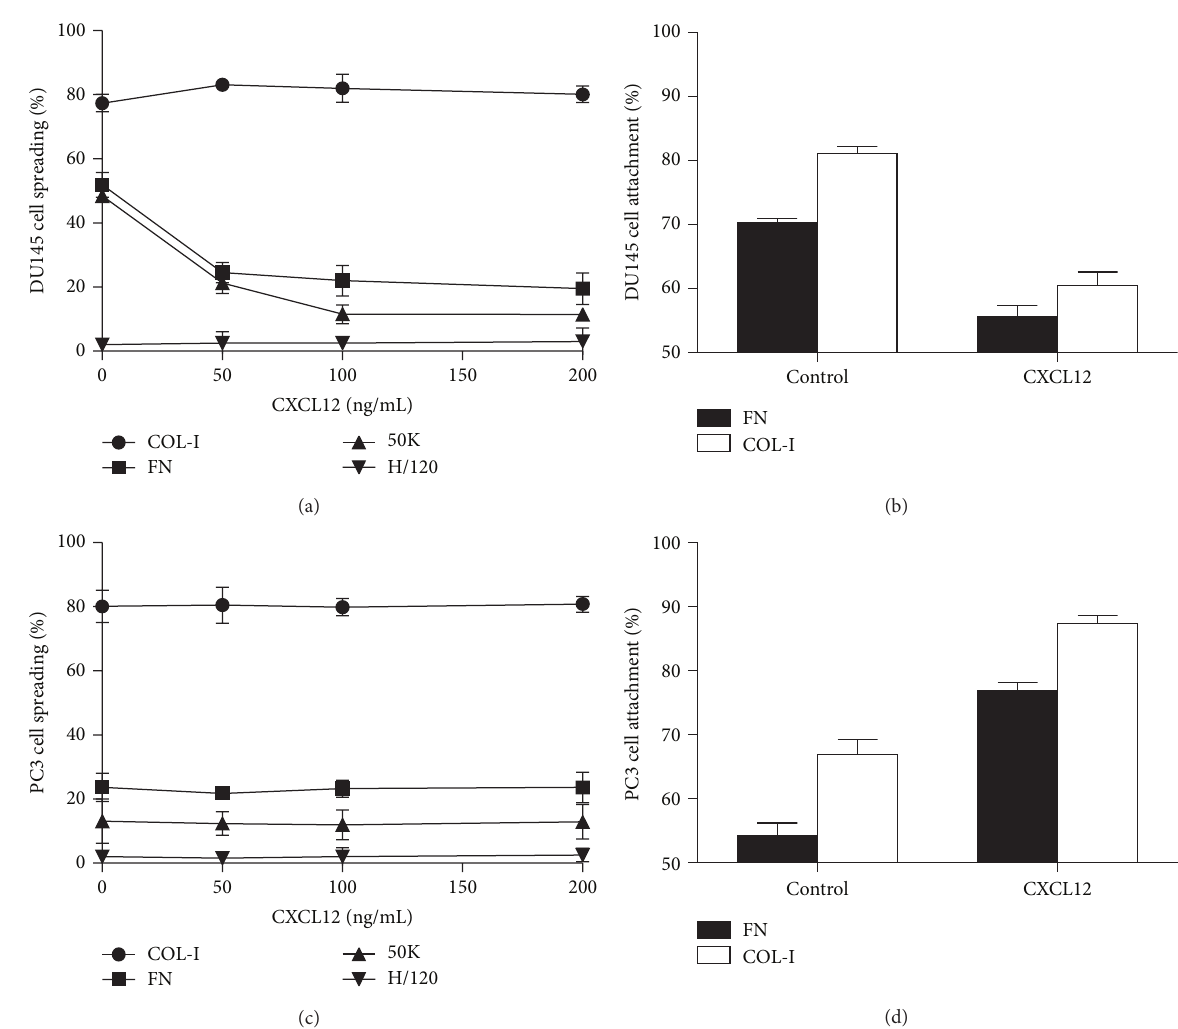
Figure 2: (a) DU145 cell spreading on COL-I, FN, 50K, and H/120 fragment of FN in the presence of various concentrations of CXCL12 (200 ng/mL). (b) Attachment of DU145 cells on FN and COL-I in the absence and presence of CXCL12 (200ng/mL). (c) PC3 cell spreading on COL-I, FN, 50K, and H/120 fragment of FN in the presence of various concentrations of CXCL12 (200ng/mL). (d) PC3 cell attachment on FN and COL-I in the absence and presence of CXCL12 (200ng/mL). The level of nonspecific binding, determined from these cells